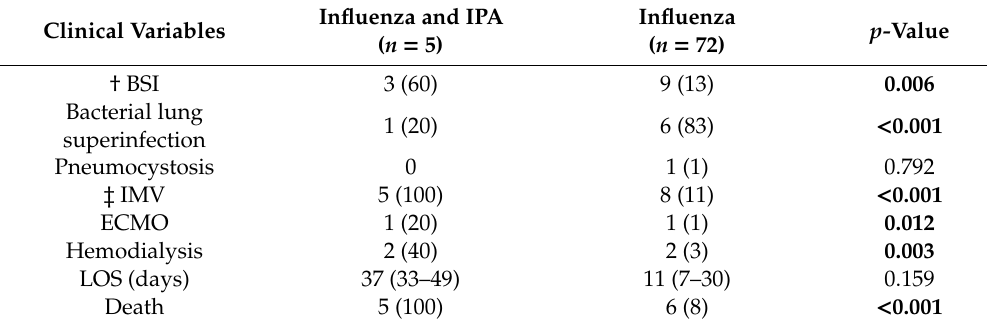
Table 4. Clinical impact of Aspergillus superinfection in patients with